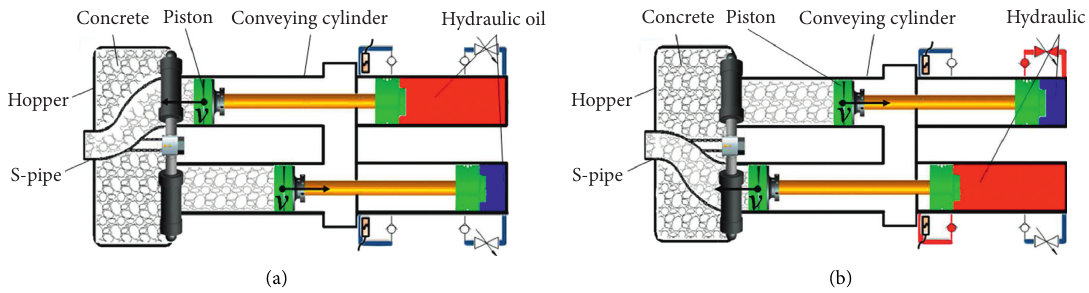
Figure 1: The pumping process before (a) and after (b) the S-pipe reversing